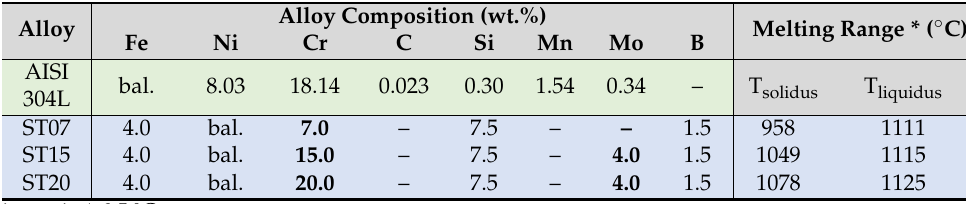
Table 1. Chemical compositions of the base material and the filler metals.